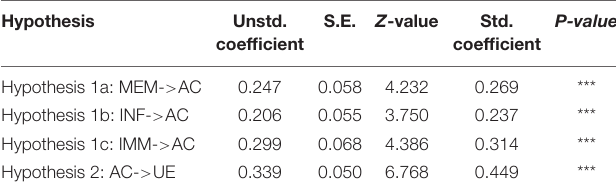
TABLE 6 | Regression coefficient.